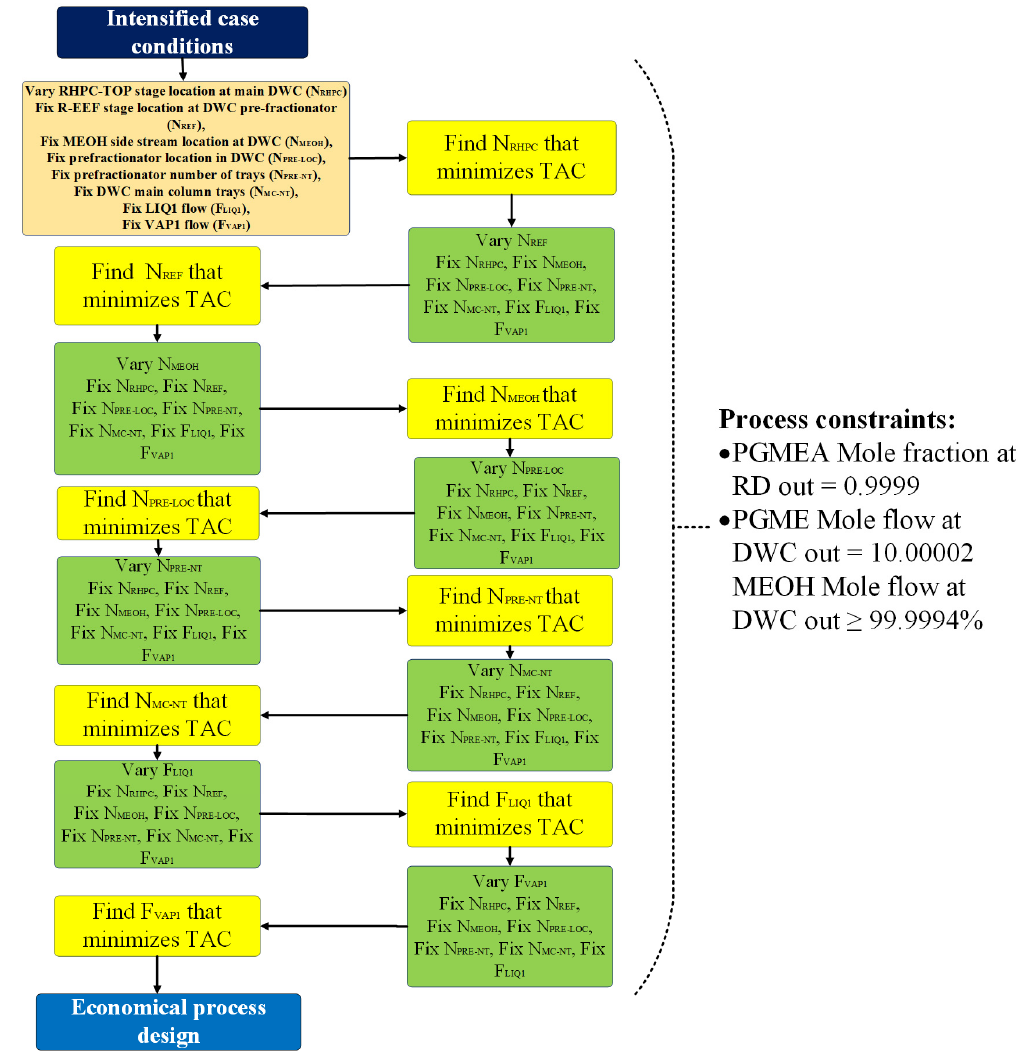
Figure 6. Flowchart for semi-iterative optimization of DWC structure.